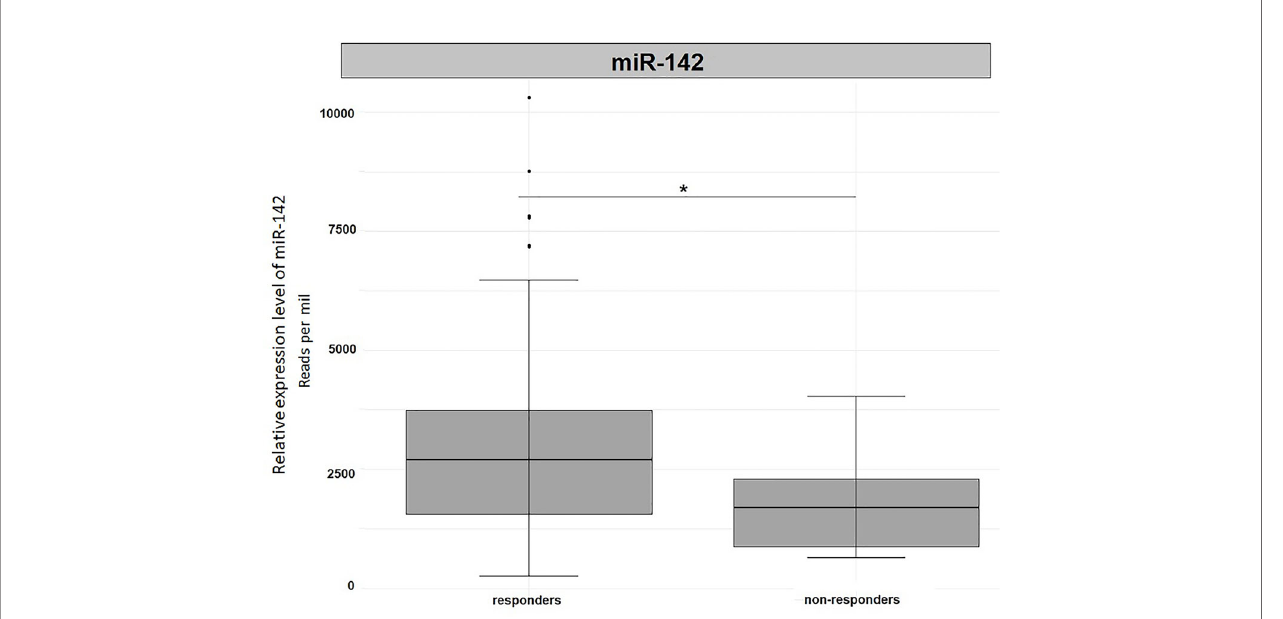
FIGURE 5 | Differential expression analysis of miR-142 in tumor tissues from TCGA-READ project strati fi ed for their responsiveness or not to therapy. *p ≤ 0.05.